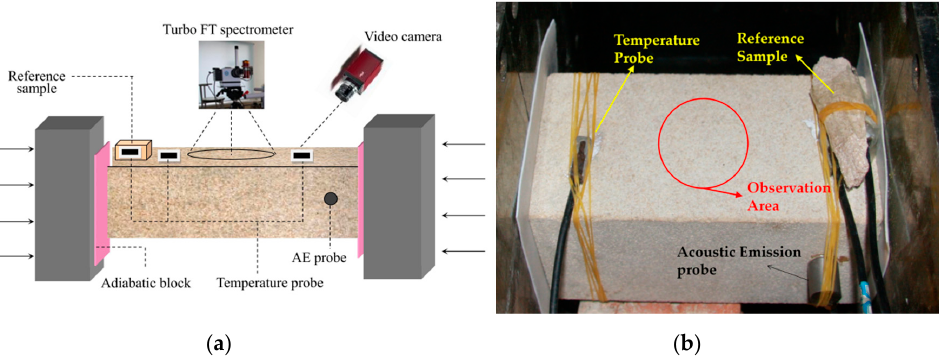
Figure 1. ( a ) Schematic diagram of the experimental system; ( b ) arrangement of the probes on the loading sandstone sample in the outdoor conditions.